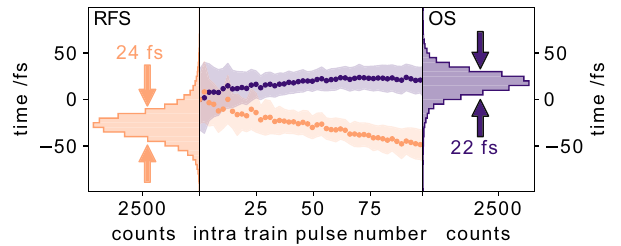
Fig. 6 | Average intra-train arrival time drifts. The average arrival times of the X-ray pulses within a pulse train are analysed in the center panel for both syn- chronisationschemes.X-raypulseswithinapulsetrainaredriftingtoearlierarrival times if the radiofrequency synchronisation scheme (RFS, orange) is used, while they are drifting to later arrival times within a pulse train for the optical synchro- nisation scheme (OS, blue). The intra-train timing distributions are shown on the left (RFS) and on the right (OS), yielding comparable full-width half maximum values when only using 100 pulses within a pulse